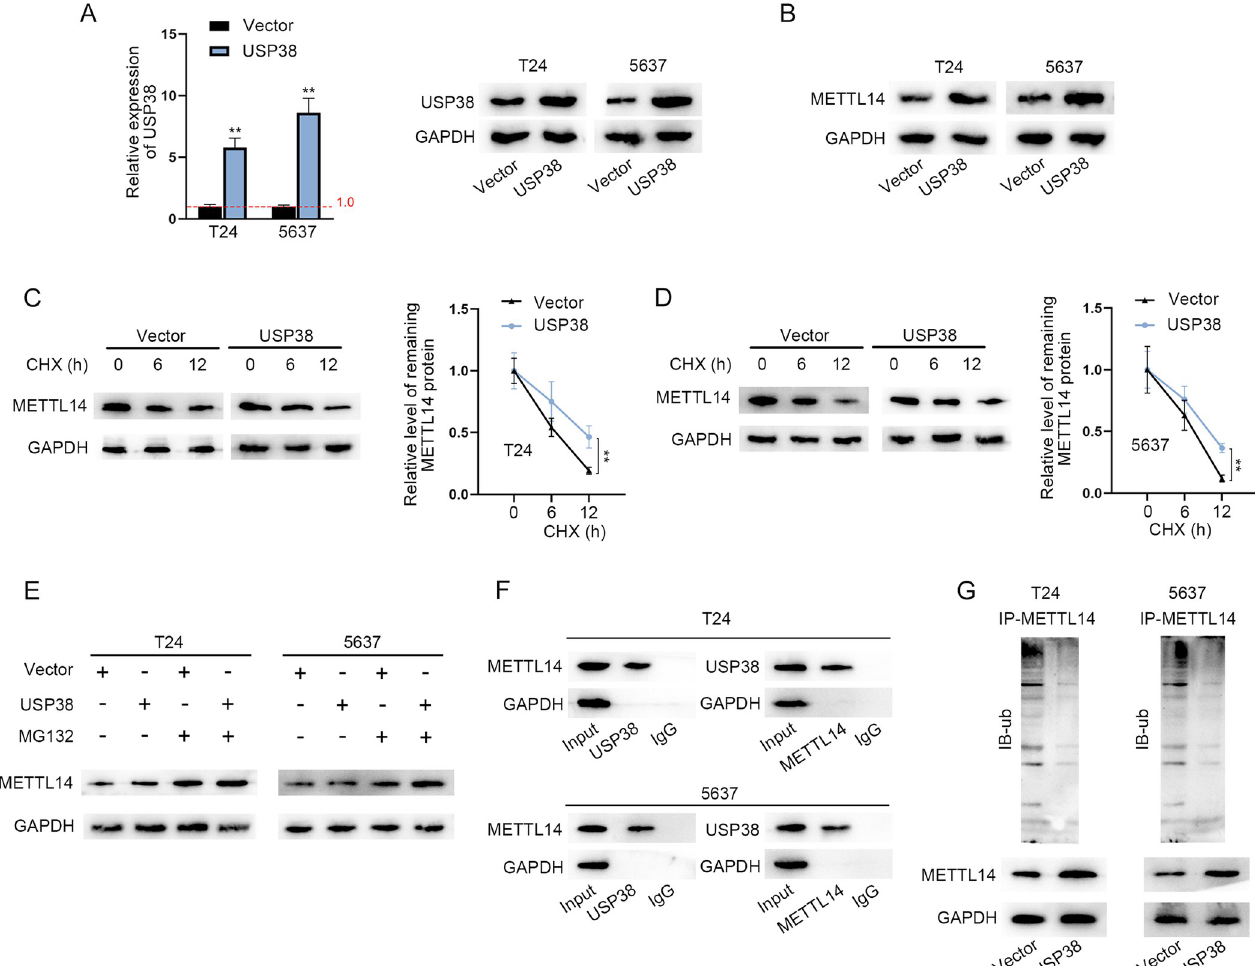
Fig 5. USP38 mediates the deubiquitination of METTL14 protein. A. RT-qPCR was used to evaluate the overexpression efficiency of pcDNA3.1-USP38 in BCa cells (left panel). (n = 3) Each bar represents mean; error bars represent SD. P values were determined by Student’s t test. Western blot of USP38 in USP38-overexpressing cells (right panels). B. Western blot was performed for the measurement of the protein level of METTL14 after the overexpression of USP38 in BCa cells. C-D. Western blot was used to detect the protein level of METL14 after the treatment of CHX for different time points (0, 6 and 12 h) before and after the upregulation of USP38 in BCa cells. (n = 3) Each point represents mean; error bars represent SD. P values were determined by Student’s t test. E. Western blot was conducted to determine the protein level of METTL14 in different groups. F. CoIP assay was implemented to investigate the co- expression of METTL14 and USP38 in BCa cells. G. IP assay followed by western blot analysis was performed to assess the ubiquitination of METTL14 before and after USP38 overexpression. �� P < 0.01. See also S4 Data.